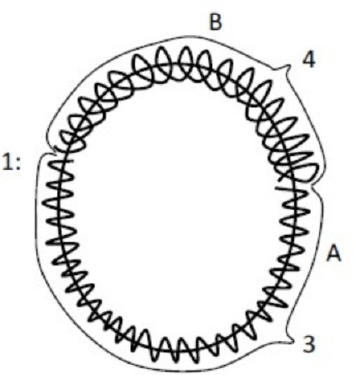
Figure 18 . All the objects of the cyclic chain of string 1 must go to either 3 or 4 and the separation objects on the cyclic chain of string 1 fall into two pieces 3 or